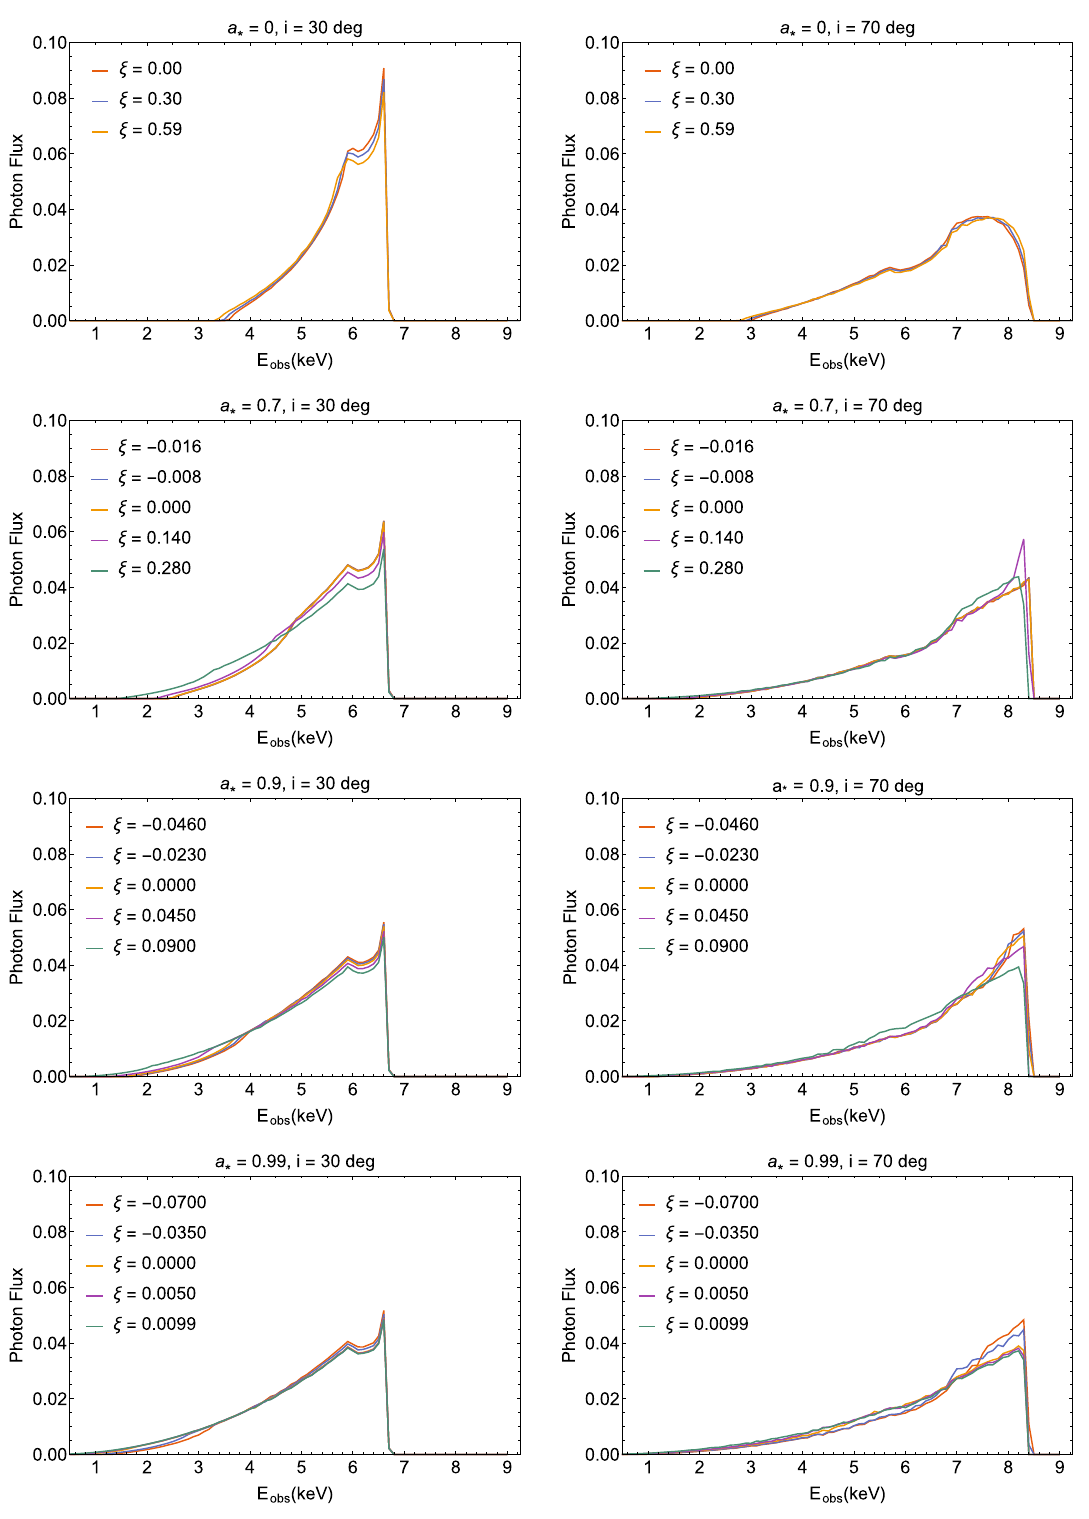
Fig. 2 Synthetic iron line shapes in asymptotically safe gravity. In all the simulations, the emissivity index is q = 3. See the text for more